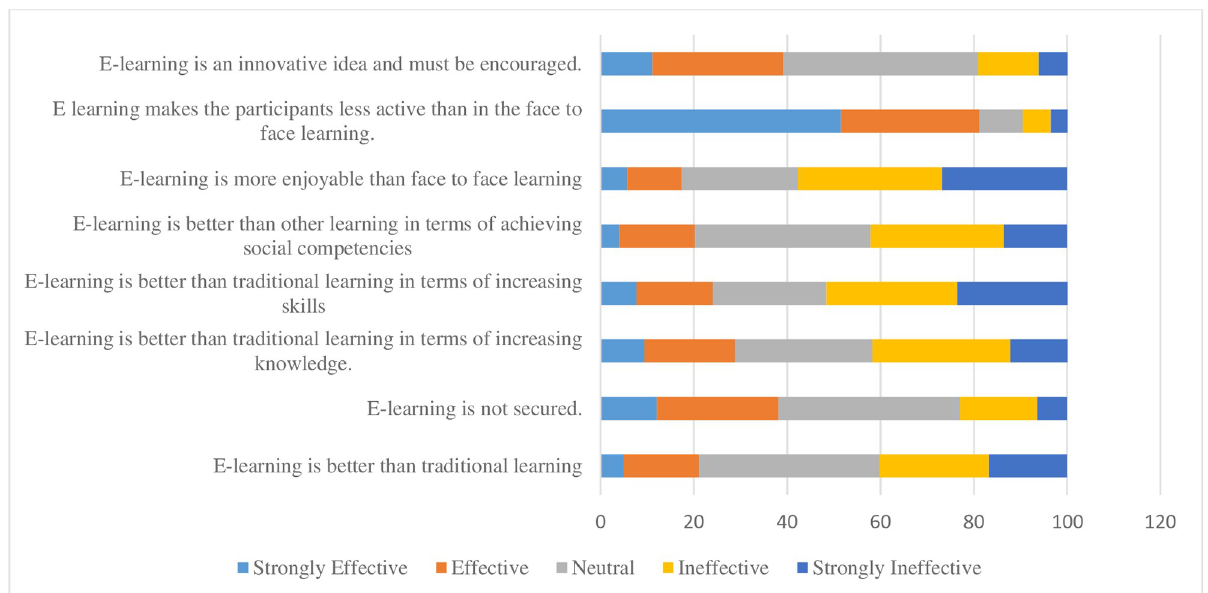
Fig 1. Comparison of the effectiveness of e-learning against traditional face-to-face learning method (n = 470).